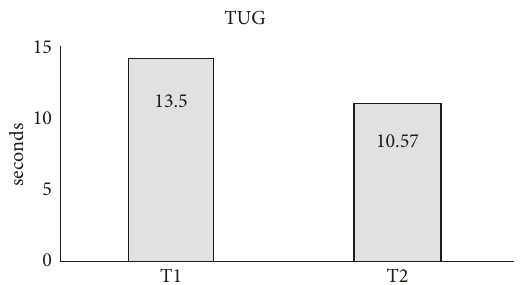
Figure 1: Average TUG before starting the kinetic rehabilitation program (1) and at the end (2).